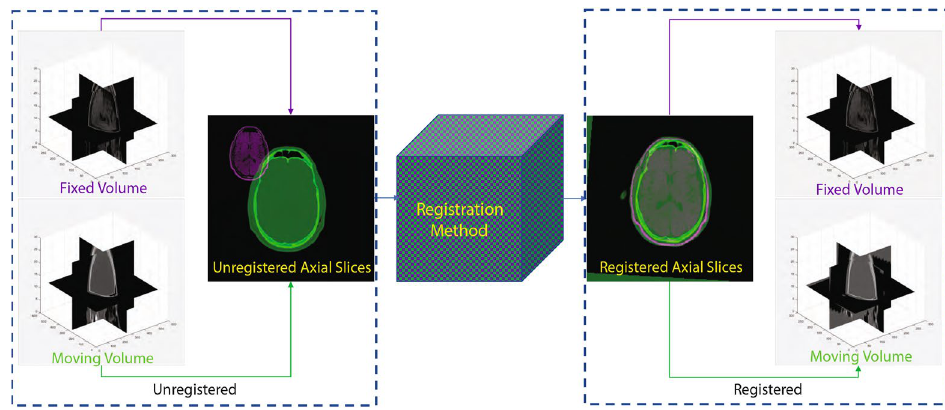
Figure 1. The process of 3D medical image